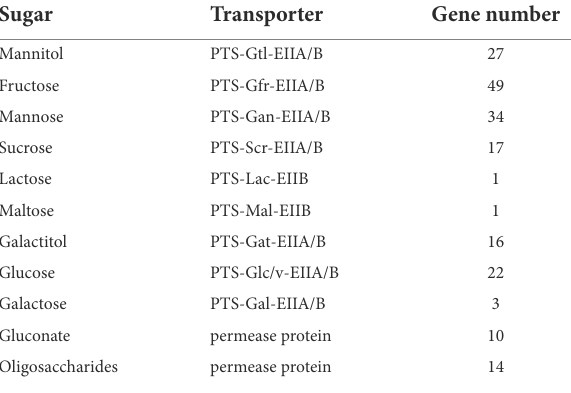
TABLE 1 Gene analysis of the sugar transport system in red vinasse